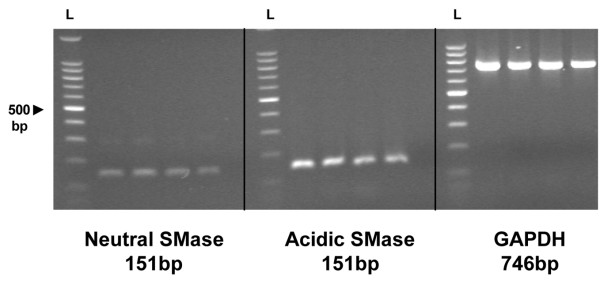
Both neutral and acidic SMase mRNAs are expressed by articular cartilage chondrocytes. Following 24 hours of culture, cells were placed into TRIZOL® (1 × 106 cells/ml) and total RNA extracted, in accordance with the manufacturer's instructions. cDNA was generated (n = 4) and PCR performed using primers specific to GAPDH, or acidic or neutral SMase (Table 1). Amplified products were separated alongside a 100 bp DNA ladder (L) on 1–2% agarose gels, containing ethidium bromide (10 μg/ml). Product sizes (bp) are indicated. bp, base pairs; GAPDH, glyceraldehyde-3-phosphate dehydrogenase; PCR, polymerase chain reaction; SMase, sphingomyelinase.